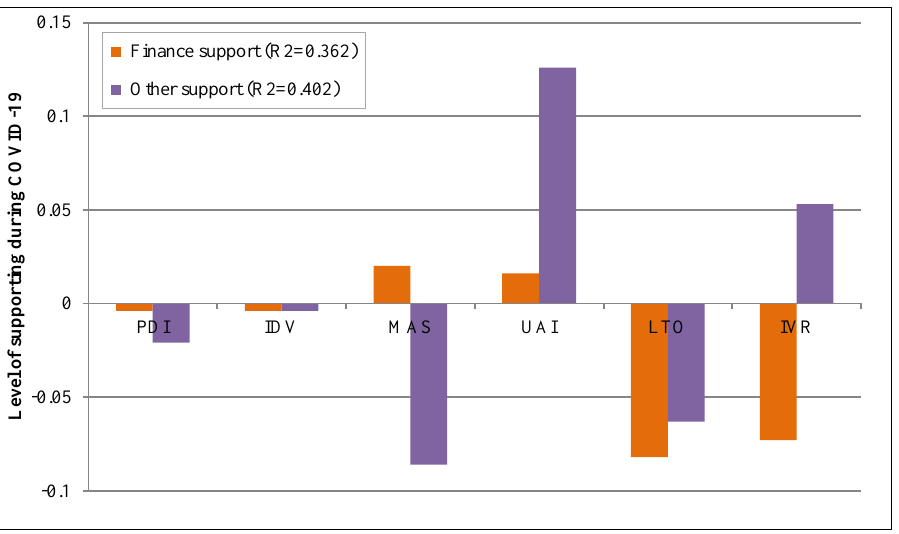
Figure 7. Supporting during